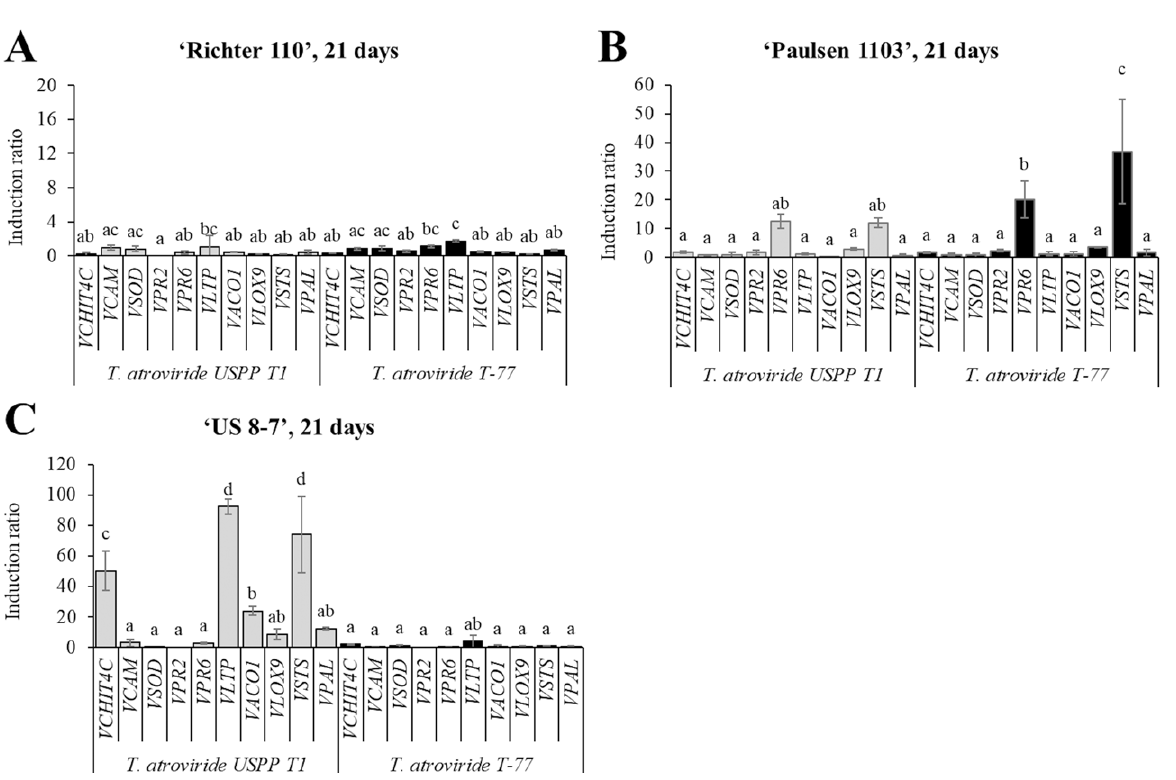
Figure 3. Mean gene induction ratios for different gene expressions (as indicated from RT-qPCR) in the leaves of grapevine rootstock cul- tivars ‘Richter 110’ (A), ‘Paulsen 1103’ (B) and ‘US 8-7’ (C) after 21 d after inoculations with Trichoderma atroviride T-77 (grey bars) or T. atroviride USPP T1 (black bars). Individual data points are means of two technical and three biological replicates. Error bars indicate stand- ard deviations of the means. Different letters accompanying the means indicate significant differences ( P ≤ 0.05; Tukey